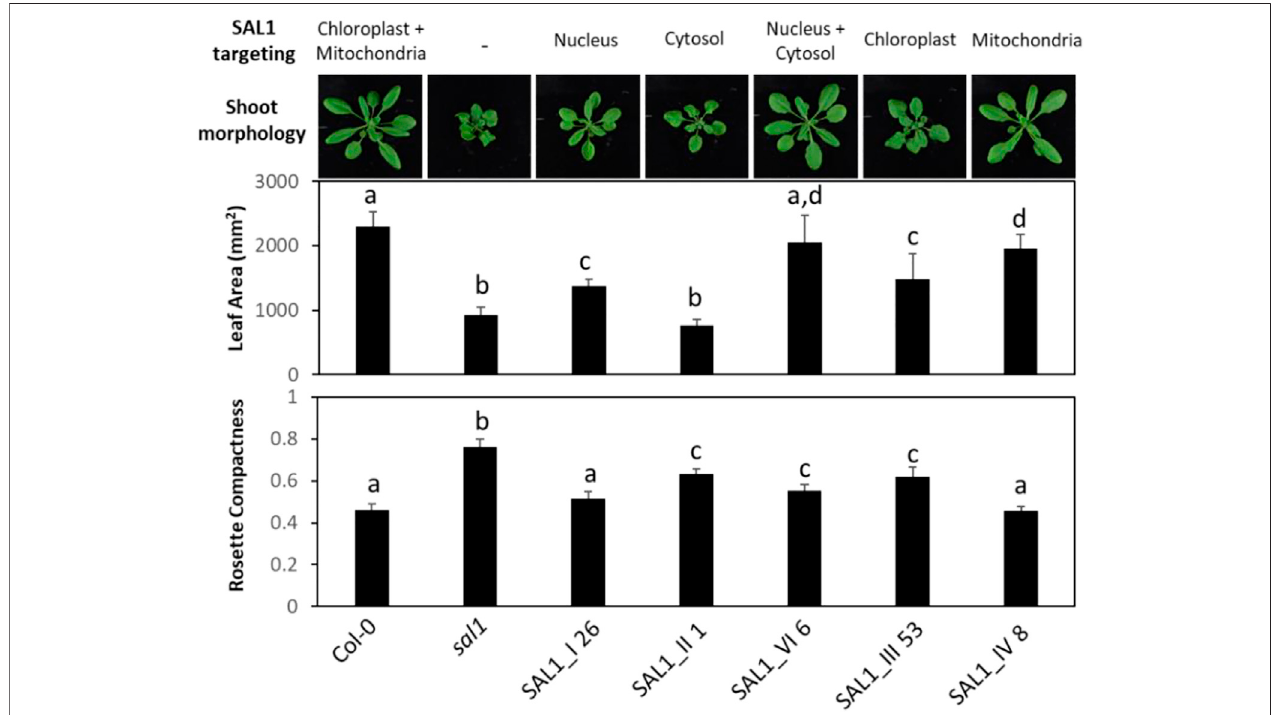
FIGURE 7 | Shoot morphology, leaf area, and rosette compactness in best-complemented sal1 mutant lines expressing SAL1 in different subcellular compartments. Morphological phenotypes were analyzed in rosette leaves of 25-day-old soil-grown plants. The entire aboveground rosette was excised and photographed under standardized lighting conditions, then the image analyzed using ImageJ to quantify the leaf area and rosette compactness. Data show the mean ± SD( n (cid:1) 5). Differentletters indicatesigni fi cantdifferencesamongmeansbasedonone-wayANOVAandTukey ’ shonestlysigni fi cantdifference(HSD) post-hoc test at p < 0.05. Note that line V_13 was not analyzed here due to the impaired germination and growth of the seeds after prolonged storage between the initial characterization ( Figures 2 – 6 ) and this analysis. Furthermore, given that V_13 utilizes the native SAL1 targeting sequence ( Figure 1 ), in our view, V_13 should be functionally similar to the wild-type control. Thus, the wild type and constructs III and IV are suf fi cient for comparing SAL1 targeting to the chloroplasts, mitochondria, or both